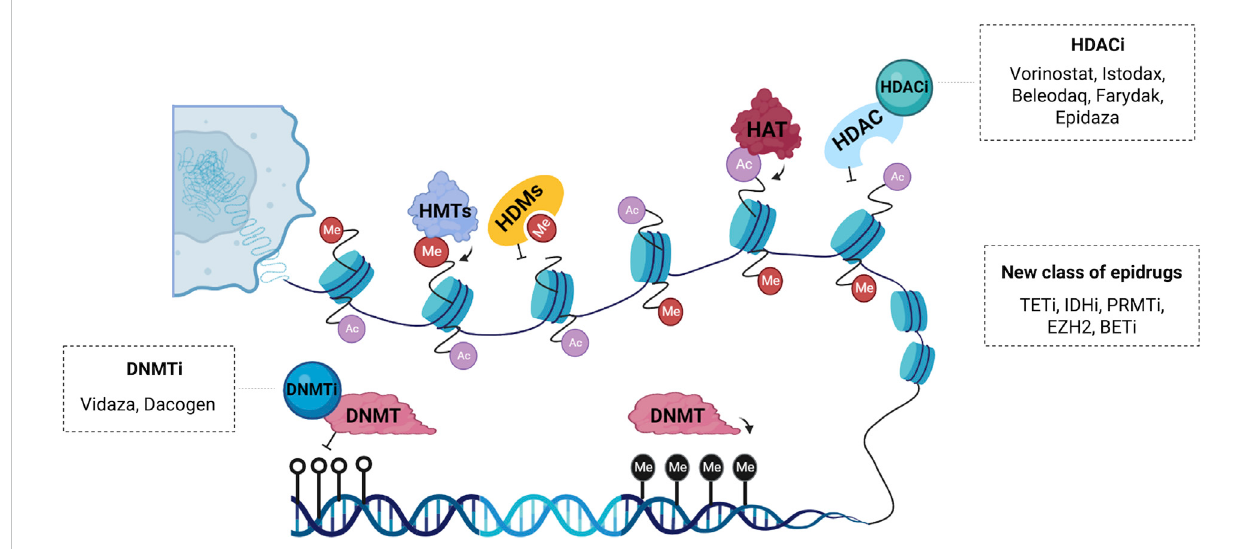
FIGURE 2 Schematic representation of the main epidrugs targets. Histone acetyltransferases (HATs) and deacetylases (HDACs) are enzymes responsible for post-translational acetylation and deacetylation, respectively. HDAC inhibitors (HDACi) such as Vorinostat ® , Istodax ® , Beleodaq ® , Farydak ® and Epidaza ® induce acetylation therebypromoting transcriptionalactivation. Histone methyltransferases (HMTs) and demethylases (HDMs) can also bemodulated by a new class of epigenetic drugs. DNA methyltransferases (DNMTs) are enzymes responsible for transferring a methyl group to carbon fi ve of cytosine, a repressive epigenetic marker. DNMT inhibitors (DNMTi) like Vidaza ® and Dacogen ® promote loss of methylation and activation of aberrantly silencedgenes.Othercompoundswithepigeneticactivityareinhibitorsoftheenzymeten-eleventranslocation(TETi),inhibitorsoftheenzymeisocitrate dehydrogenase (IDHi), inhibitors of the protein arginine methyltransferase (PRMTi), inhibitors of the bromodomain and extra-terminal domain (BETi) and inhibitors of the enhancer of zeste homolog 2 (EZH2i), which is a histone-lysine n-methyltransferase